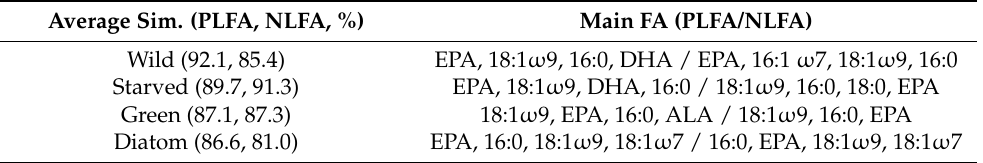
Table 1. Similarity percentage (SIMPER) analysis was used to assess similarity between NLFA and PLFA fraction in different treatments. Listed FA contributes >70% of all similarity within lipid class of different